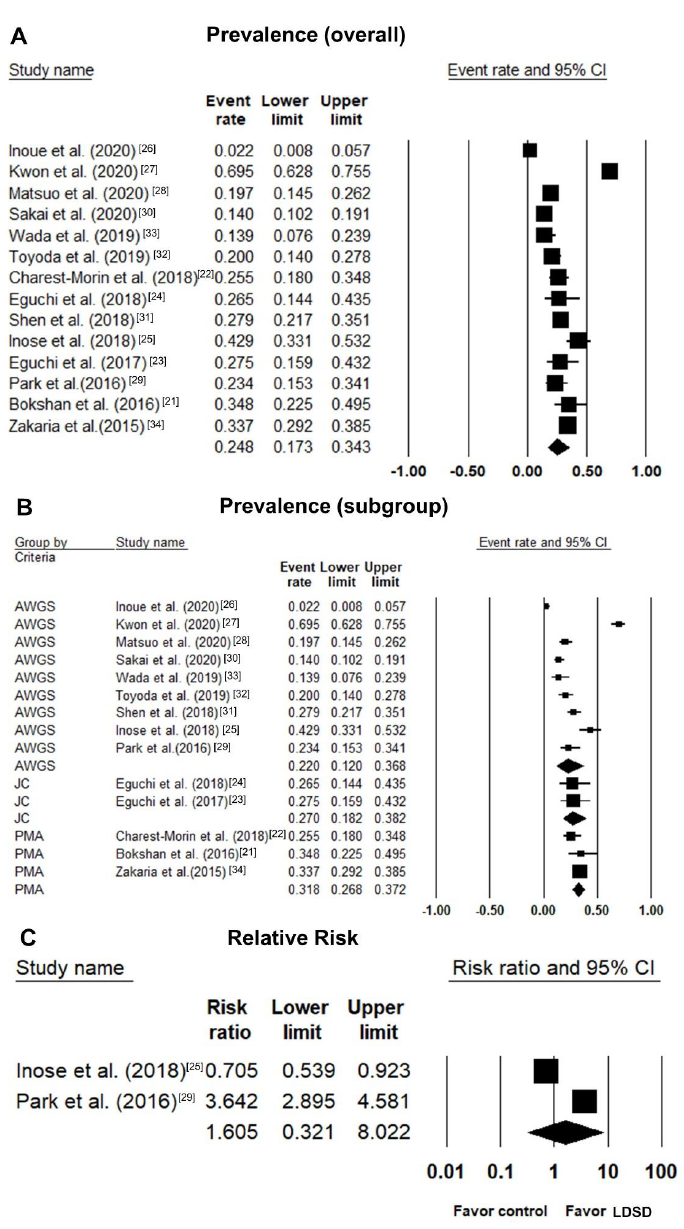
Figure 2. Forest plot of the overall prevalence of sarcopenia in patients with lumbar degenerative spine disease ( A ); the subgroup analysis of the prevalence of sarcopenia based on the different diagnostic criteria ( B ); the relative risk of sarcopenia in the group with lumbar degenerative spine vs. controls ( C ).;AWGS: the consensus of Asian Working Group for Sarcopenia; JC: criteria specific for the skeletal muscle mass index of the Japanese population; PMA: psoas muscle cross-sectional area; CI: confidence interval; LDSD: lumbar degenerative spine